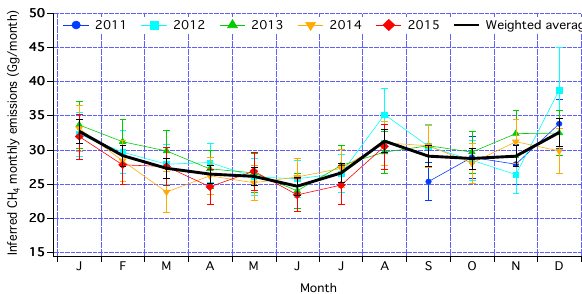
Figure 7. Monthly patterns of derived CH 4 emissions (in unit of Gg per month). Error bars represent the ± 1 σ uncertainties. De- rived CH 4 emissions are color-coded as follows: 2011 in blue, 2012 in cyan, 2013 in green, 2014 in orange, and 2015 in red. Average monthly emissions and their standard deviations over the entire ob- servational period are shown in